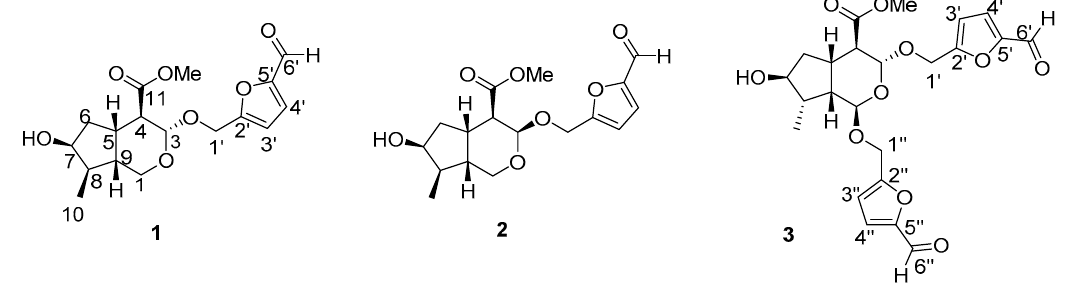
Figure 1. The structures of compounds 1 – 3.